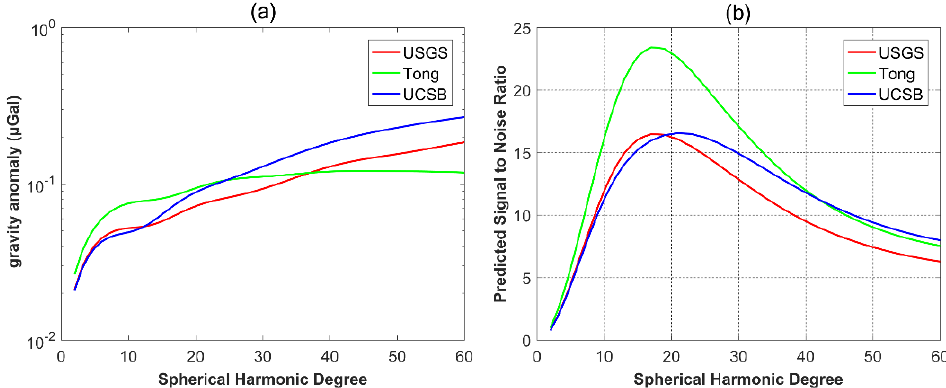
Figure 10. ( a ) Degree amplitude spectra of 2010 Mw8.8 Maule coseismic gravity changes predicted by different fault slip models. ( b ) SNR of 2010 Mw8.8 Maule based on different fault slip models in spectral domain. The red, green and blue lines represent USGS, Tong and UCSB model, respectively.